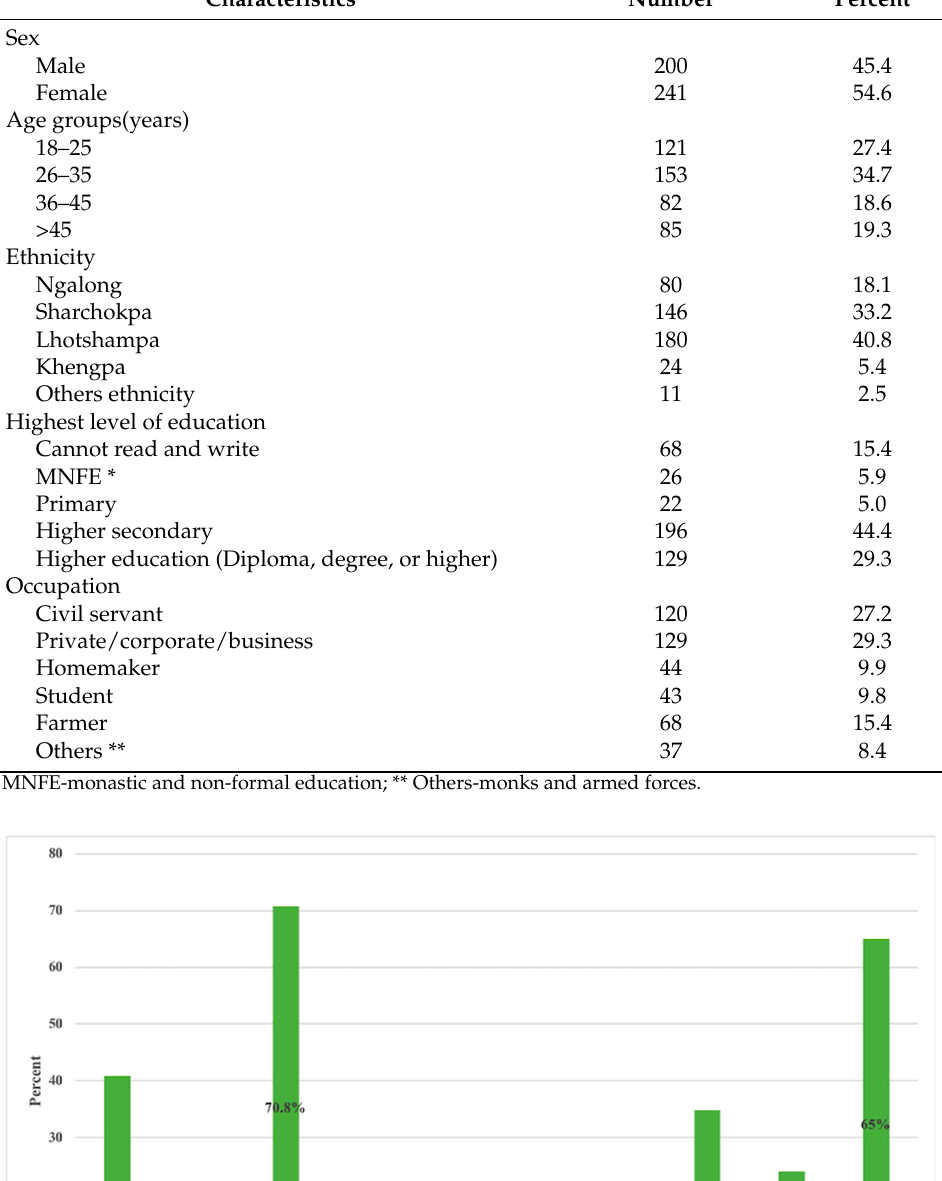
Table 1. Demographic characteristics of the participants in Phuentsholing Hospital, Bhutan.